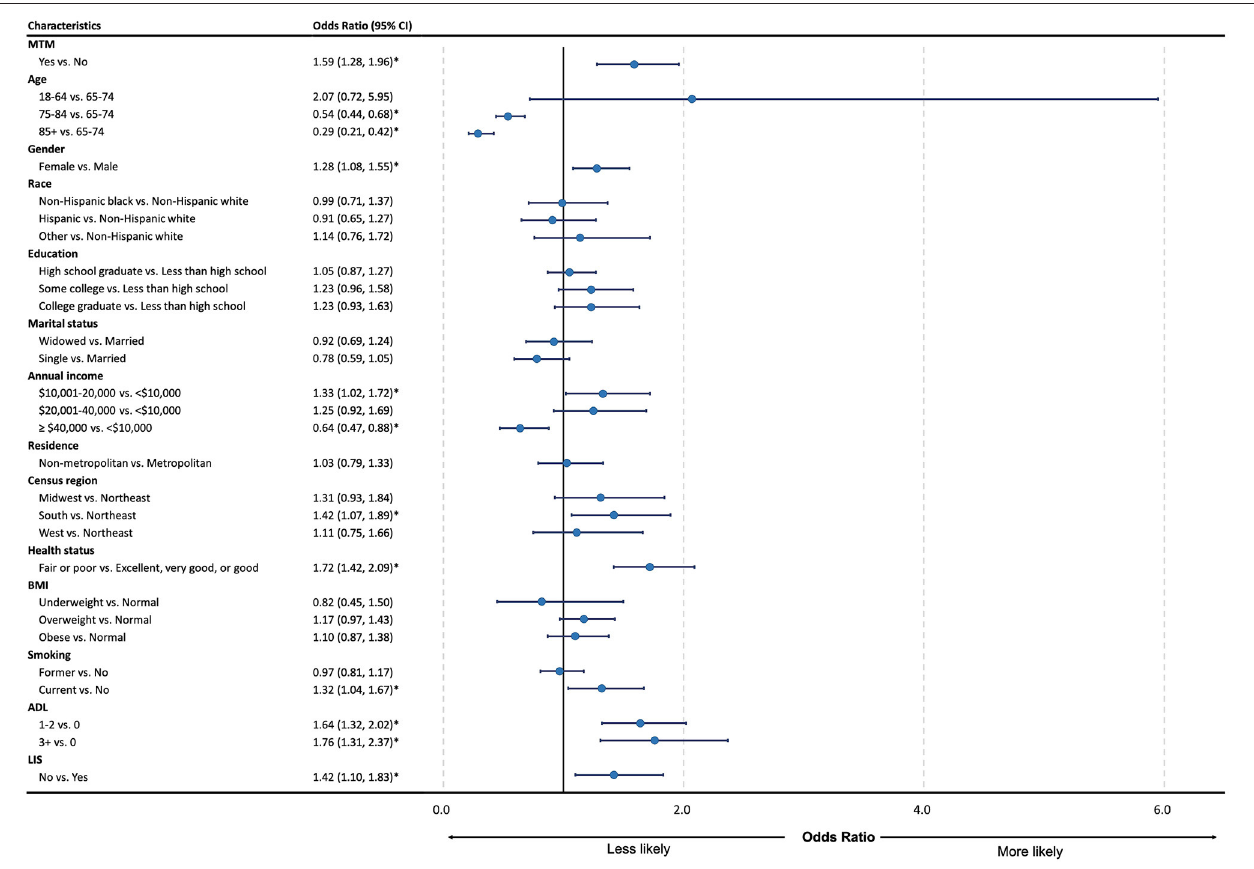
FIGURE 1 | Forest plot for odds ratio and 95% CI of regression for cost-related medication non-adherence among the study group. MTM, medication therapy management; CRN, cost-related non-adherence; BMI, body mass index; ADL, activities of daily living; LIS, low-income subsidy; CI, confidence interval; LL, lower limit; UL, upper limit. * P <